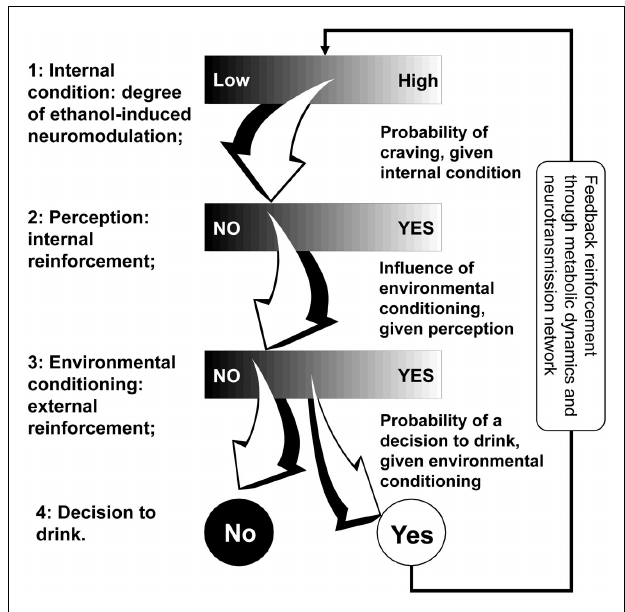
FIGURE 2 | Stochastic model of behavioral and social